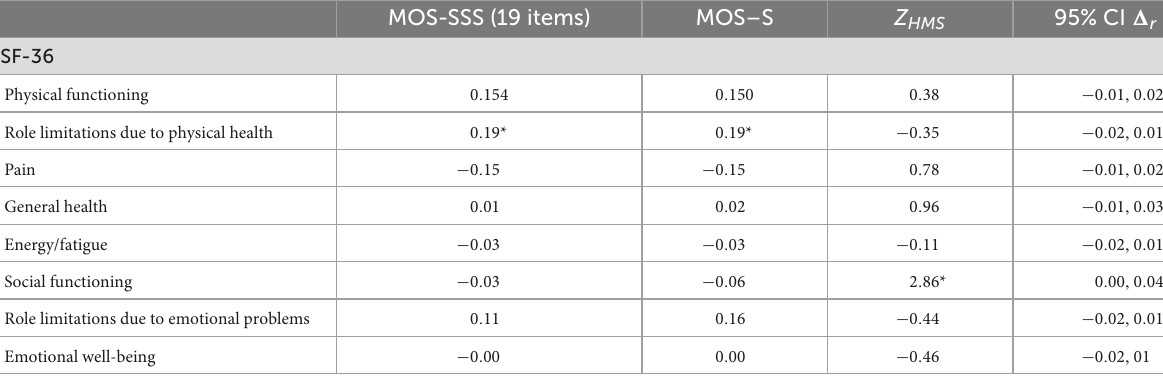
TABLE 8 Association with other variables: comparison MOS-SSS vs.